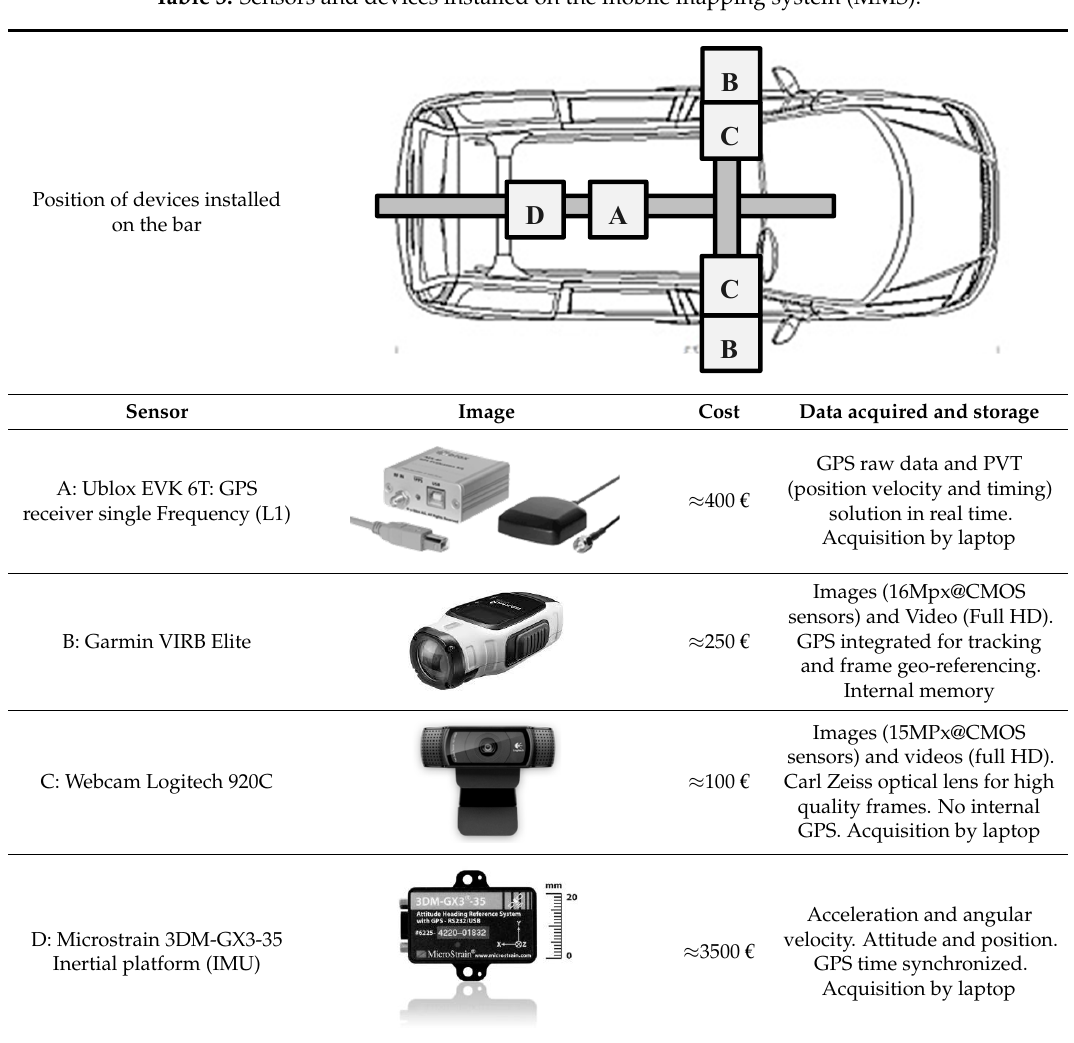
Table 3. Sensors and devices installed on the mobile mapping system